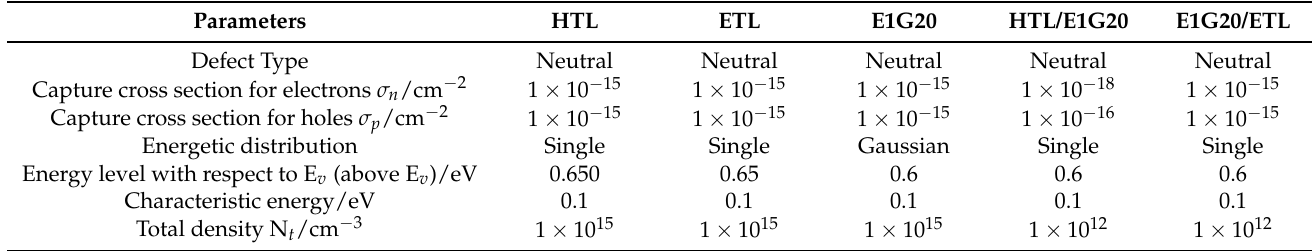
Table 4. Defect density values inside the layers and at interfaces of the